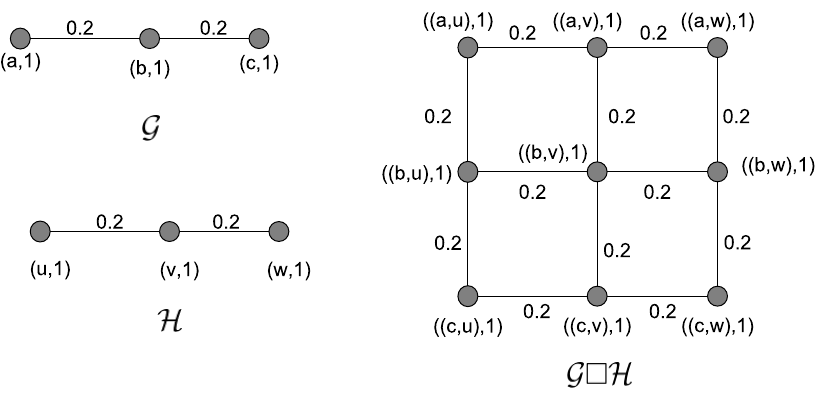
Figure 7: Fuzzy Graphs G , H and G (cid:50)